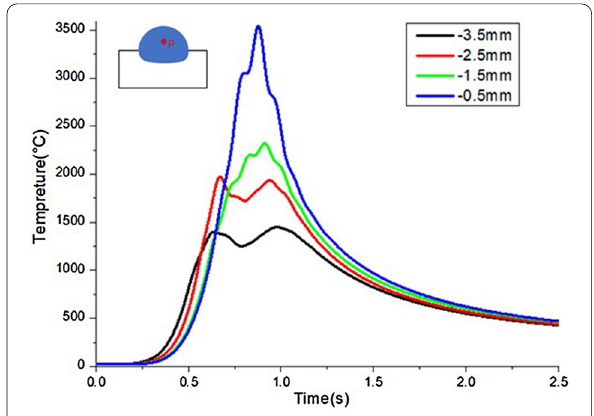
Figure 15 Temperature history at center of clad with respect to different defocus